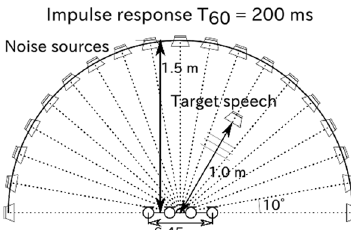
Fig. 2 Recording situation of impulse